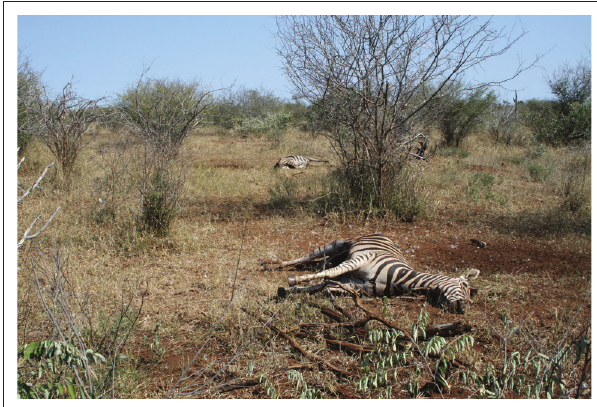
FIGURE 9: Zebra mortalities – Shilolweni